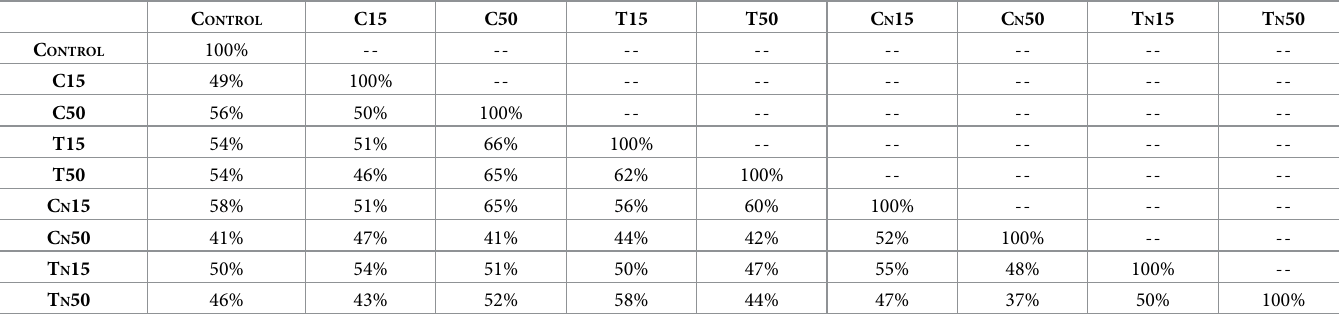
Symbols: C; Control, C15; chlorntraniliprole LC 15 , C50; chlorntraniliprole LC 50 , Cn15; nano-chlorntraniliprole LC 15 , Cn50; Nano-chlorntraniliprole LC 15 , T15;